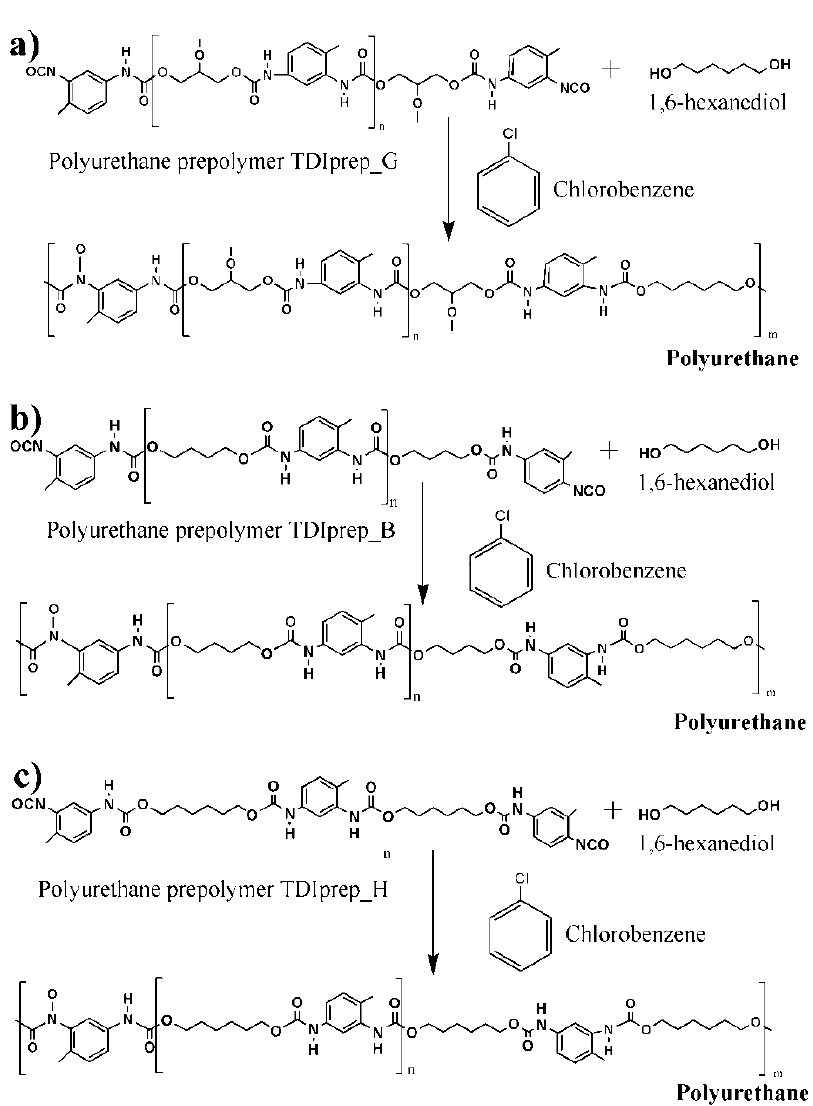
Figure 2. Schematic presentation of polyurethane microcapsule shell wall synthesis, using 1,6 ‐ hexanediol as chain extender and prepolymers toluene 2,4 ‐ diisocyanate–glycerol ( a ), toluene 2,4 ‐ diisocyanate ‐ 1,4 ‐ butanediol ( b ), and toluene 2,4 ‐ diisocyanate ‐ 1,6 ‐ hexanediol ( c ).